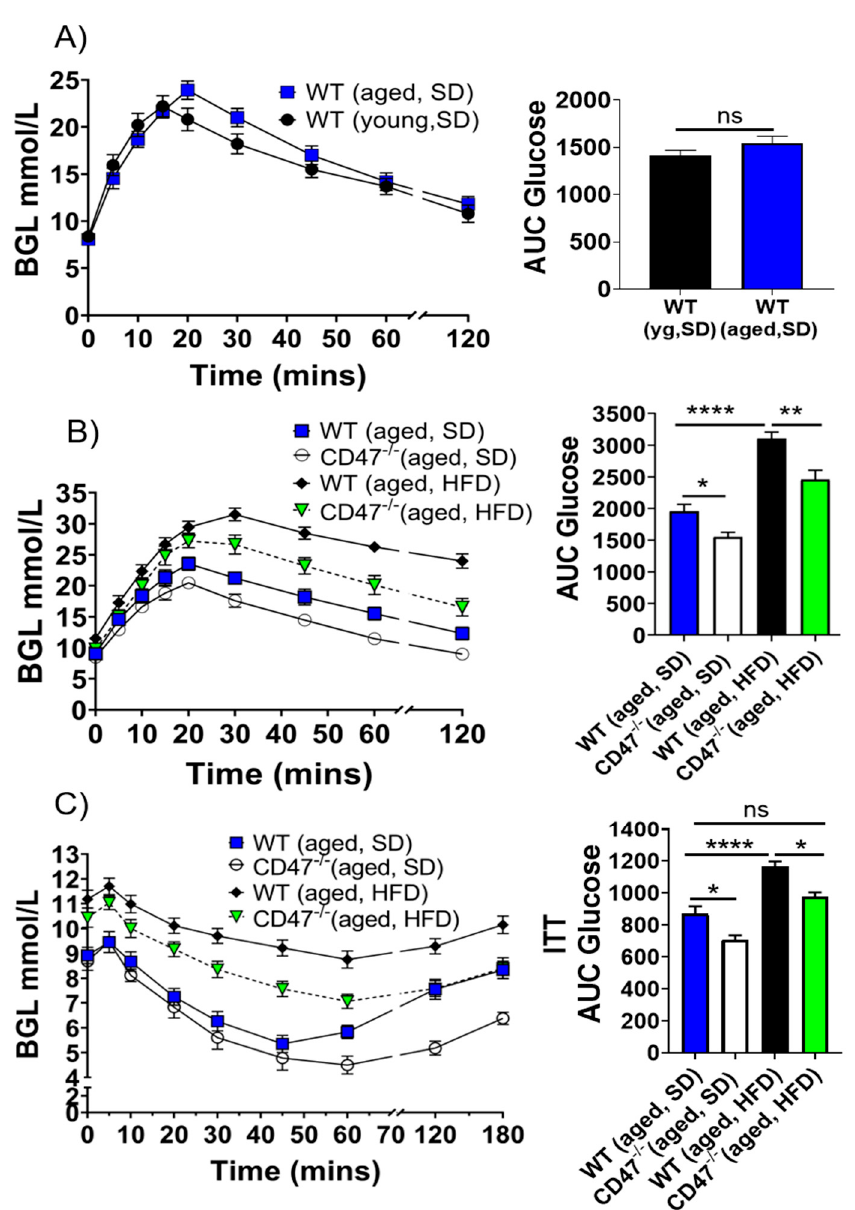
Figure 8. Aspects of age-related metabolic syndrome are attenuated in the absence of CD47. Intraperitoneal glucose clearance test results between young and aged wild-type (WT) mice ( A ), between aged WT and CD47-null mice on standard diet (SD) and high fat diet (HFD) ( B ). Insulin sensitivity test results between aged WT and CD47-null mice on SD and HFD ( C ). Six to eight animals / group. BGL: Blood glucose level. Error bars represent the mean ± SEM. An unpaired t -test between two groups and 1-way ANOVA, followed by a Tukey’s multiple comparison test for more than 2 groups. * p < 0.05, ** p < 0.01, **** p < 0.0001, ns: non-significant.